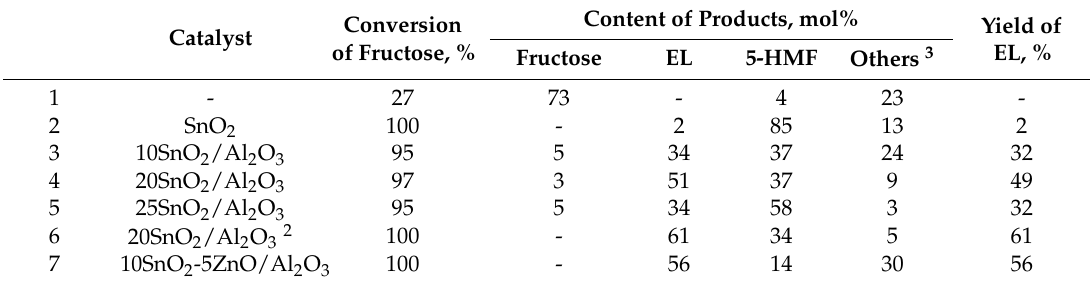
Table 2. Product content of fructose conversion.